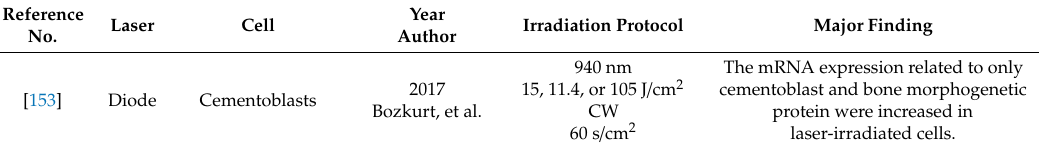
Table 5. Summary of the e ff ects of laser irradiation on